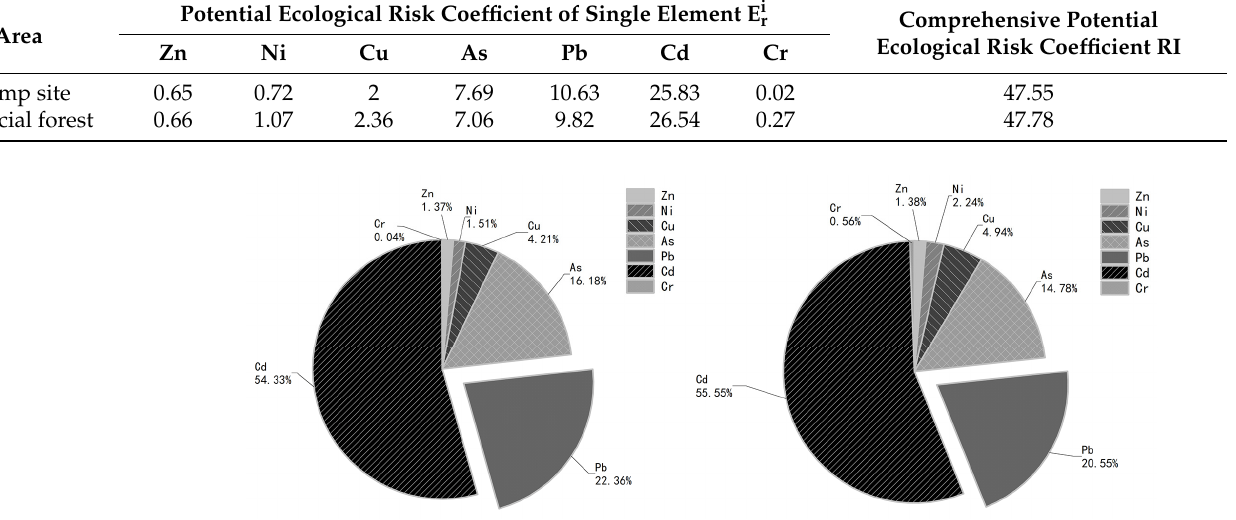
Figure 4. Potential risk contribution diagram of heavy metals ( left for dump site, right for artificial forest).